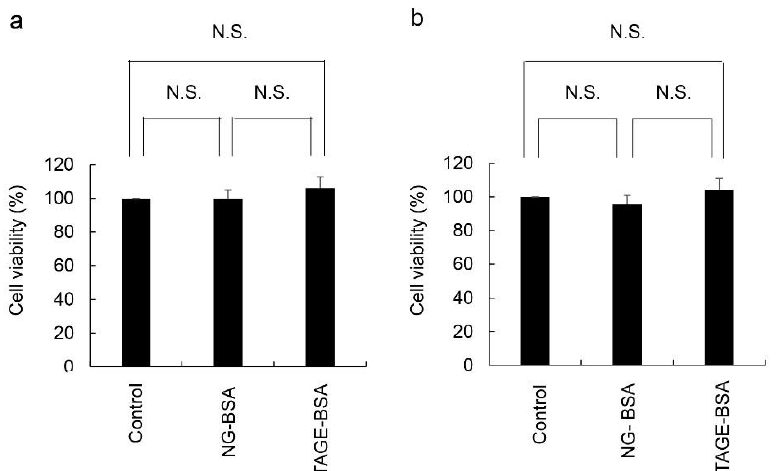
Figure 1. Viability based on NADPH activity and accumulated levels of intracellular TAGE in GA- and AG-treated HCF (1.0 × 10 4 cells/cm 2 ) incubated in fibroblast growth medium-3. ( a , b ) effects of treatments with 0, 1, 1.5, and 2 mM GA for 24 h; ( c , d ) effects of pretreatments with 0 or 16 mM AG for 2 h, followed by 0, 1, and 2 mM GA for 24 h; ( a , c ) NADPH activity was measured to calculate cell viability in four independent experiments. Data are shown as the mean ± S.D (n = 4). ( b , d ) The SB analysis was performed to assess the accumulated levels of intracellular TAGE. Data are shown as the mean ± S.D (n = 3). P-values were determined using Tukey’s test. ( a , b ) *p < 0.05 vs 0 mM GA **p < 0.01 vs 0 mM GA. ## p < 0.01. N.S.: not significant ( c , d ) **p < 0.01 vs 0 mM GA without AG. ## p < 0.01.